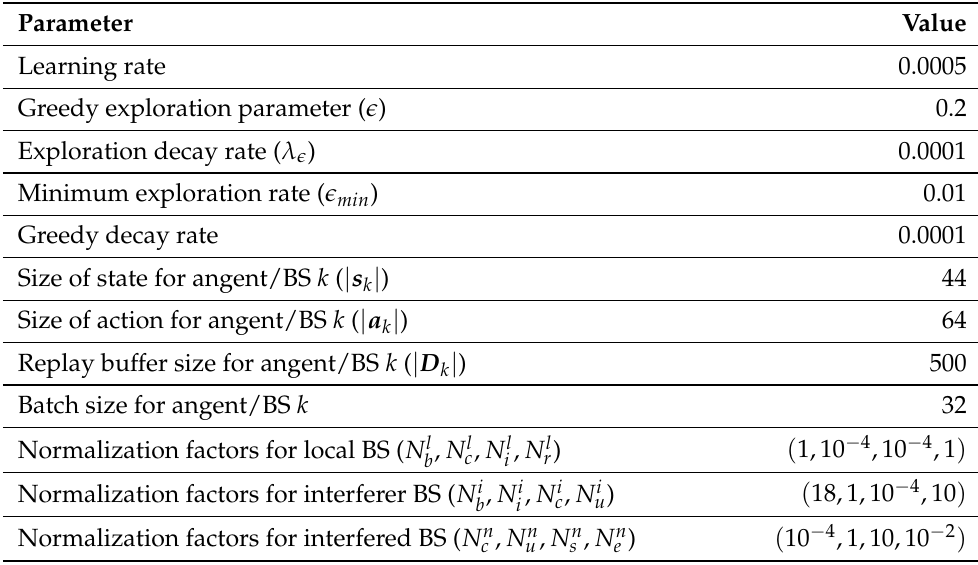
Table 2. Parameters and hyperparameters for